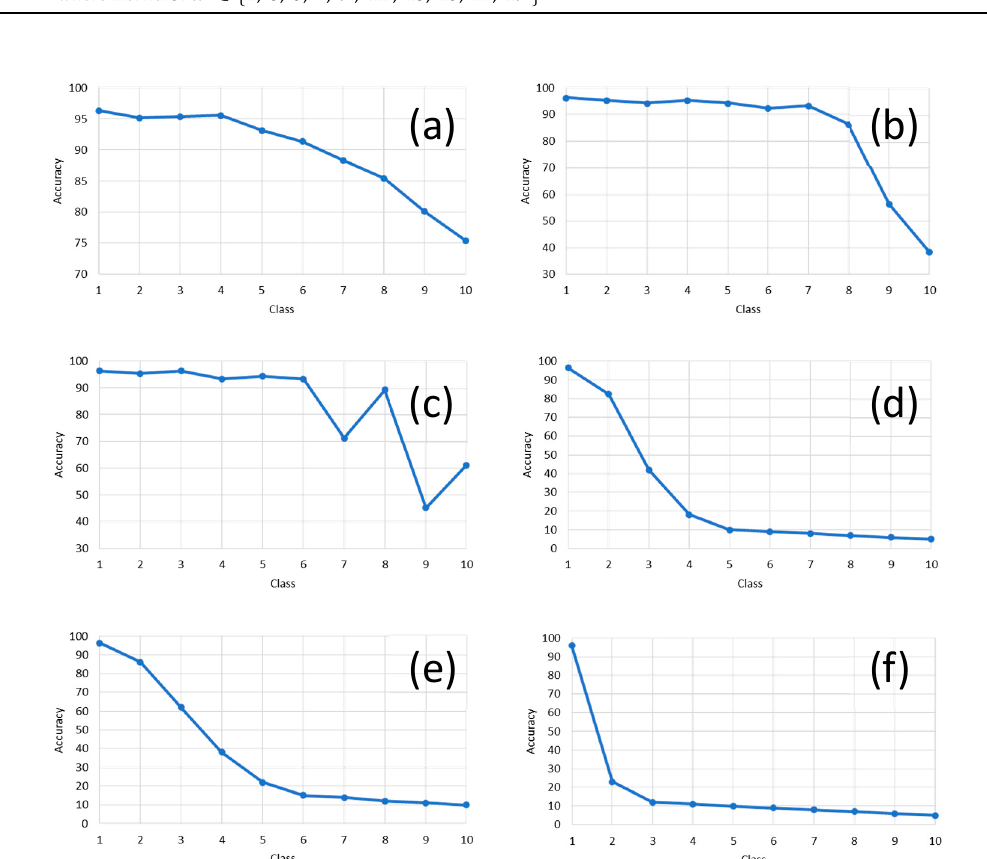
Figure 16. The effect of different artifacts on our best classifier’s accuracy (Model V) and a comparison with other related works. The class value (on the x-axis) shows the amount of injected distorting artifacts (i.e., distortion level) in the original